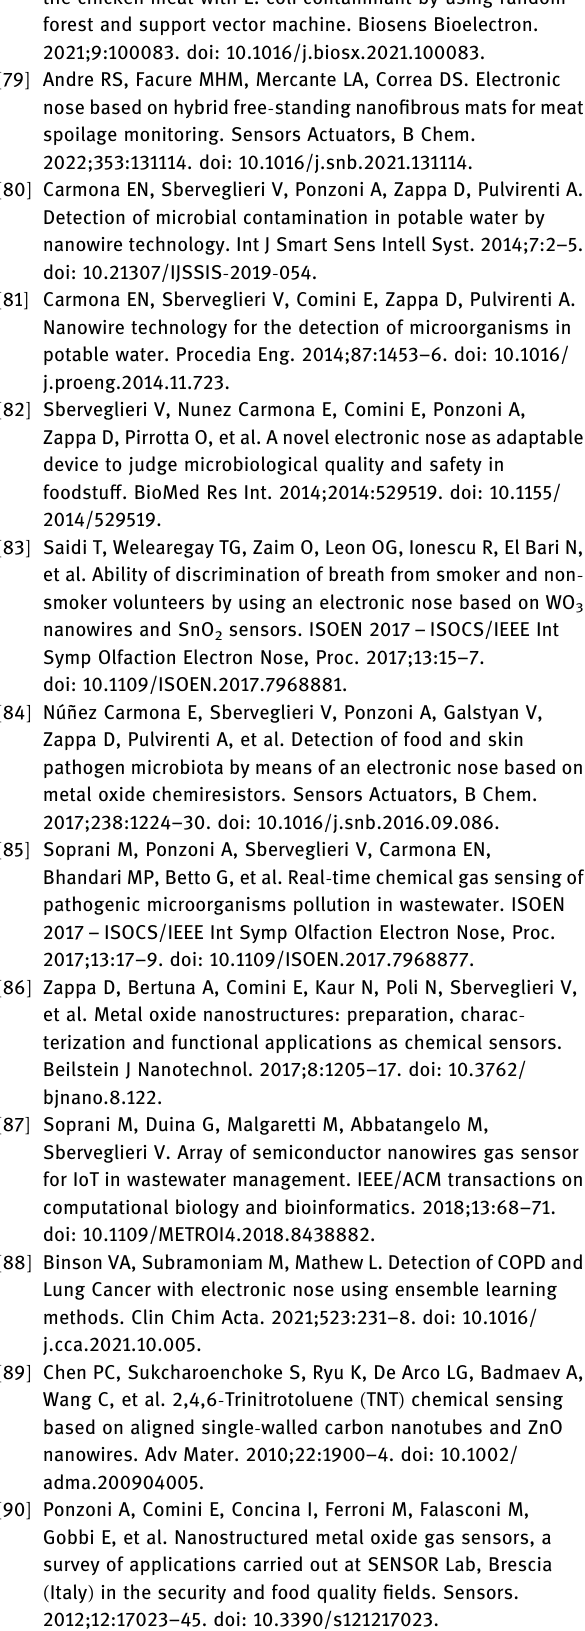
table e - nose system for fast diagnosis of white fl y infestation